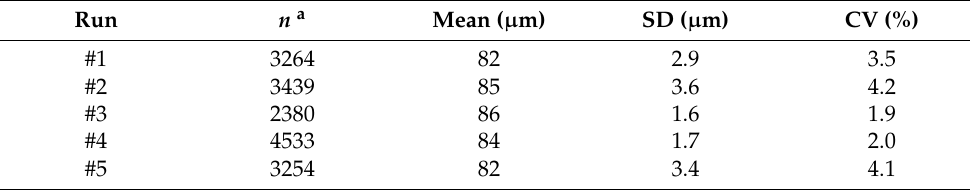
a Total droplet sample size. SD, standard deviation; CV, coefficient of variation. Note that the mi- crochip was degassed before each run.